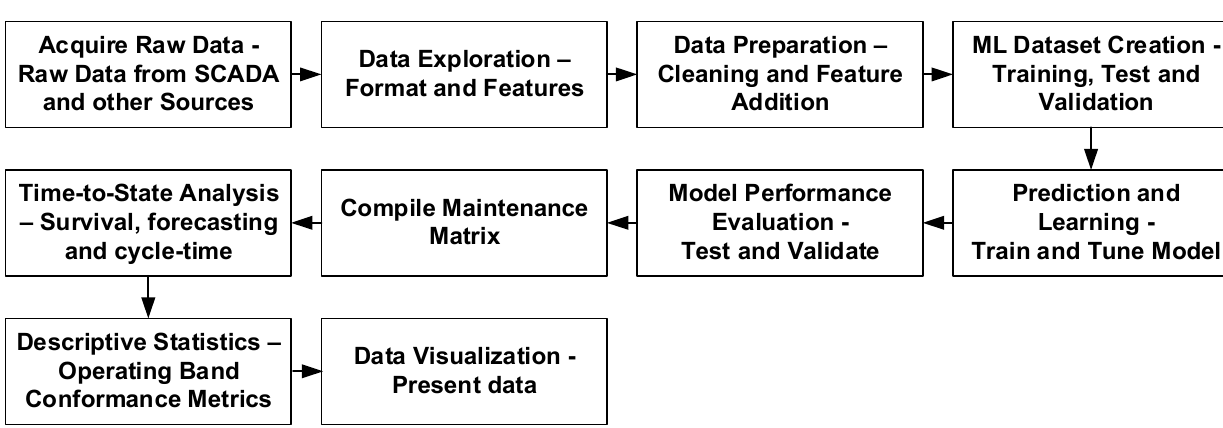
8 of 26 Table 1. Instrument Overview.